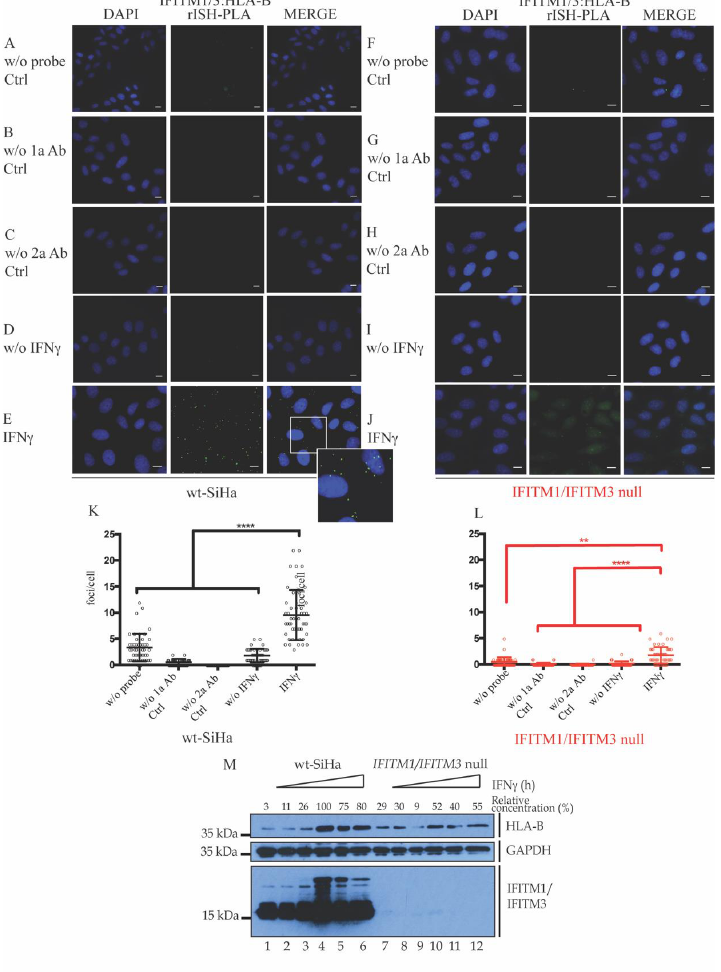
Figure 2. Evaluation of the IFITM1/IFITM3:HLA-B protein – RNA interaction in situ after stimulation with IFNγ by rISH–PLA. RNA in situ hybridization — PLA assays were used to study the endogenous interaction between HLA-B mRNA and IFITM1/3 proteins in wt-SiHa cells ( A – E ) and IFITM1/IFITM3 null cells ( F – J ). A biotinylated probe was designed to bind specifically the HLA-B mRNA. IFITM1/3:HLA-B rISH-PLA images identify the protein – RNA association foci (green) and DAPI was used for nuclear staining (blue). ( A – C , F – H ) Cells were incubated as negative controls without the RNA probe ( A,F ), using primary antibodies only ( B,G ), or secondary antibodies only ( C,H ). Cells were incubated with both IFITM1/IFITM3 and biotin antibodies to define protein – RNA foci in nonstimulated cells ( D,I ) or IFNγ -stimulated cells ( E,J ). Magnification of selected area at the bottom right of merge ( E ). Representative quantification of the protein – RNA interaction foci per cell in presence or absence of IFNγ stimulation in wt -SiHa cells ( K ) and IFITM1/IFITM3 null cells ( L ). At least 50 cells were counted in each condition. Statistical study was performed with one-way ANOVA and Bonferroni correction (**** p < 0.0001, ** p < 0.01). n = 3. Scale bar: 10 μ m. A time course of 0, 4, 6, 24, 48, and 72 h with 100 ng/mL INFγ